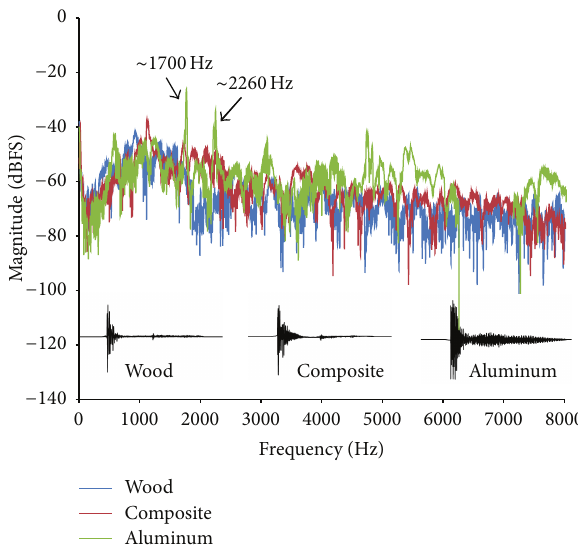
Figure 2: Time domain wave forms and spectra. The time domain wave forms are shown in black with energy lasting on average around 0.1 seconds. As can be seen, the aluminum bat wave form shows signs of “ringing” beyond the initial impulse. The spectra of the three highest bat measurements are shown in blue (wood), red (composite), and green (aluminum). Although all three bat spectra are broad in nature, the aluminum bat has somewhat higher energy between 4000 and 8000 Hz, and the two distinct peaks at approximately 1700 and 2260 Hz are shown. These peaks are at least 20 dB above the rest of the broadband energy (noise